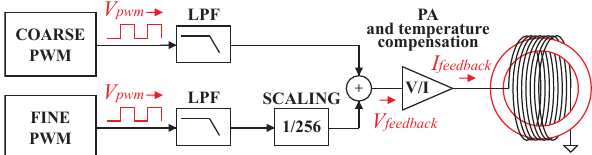
Fig. 7. Block diagram of the dual pulse width modulation feedback network of the prototype instrument. The output is built up from two 10 bit PWMs at 14400Hz and low-pass filtered at 1kHz. The two PWMs are scaled to overlap by two bits, summed, and con- verted into a feedback current using an intentionally mis-balanced transconductance amplifier to temperature compensate the feedback